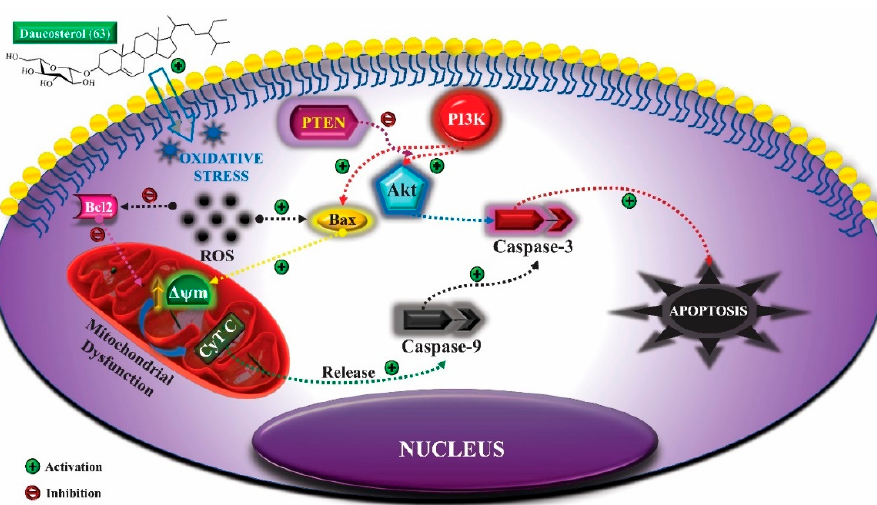
Figure 7. Daucosterol mechanism on human breast adenocarcinoma cells: After treatment of tumor cells (MCF-7) with daucusterol, a phytosterol abundantly present in Bromelia antiacantha extracts, the positive regulation of Phosphatase and Tensin Homologue (PTEN) blocks Protein Kinase B (Akt) activation through PI3K. Daucusterol induces reactive oxygen species (ROS) synthesis that leads to mitochondrial oxidative stress and, subsequently, release of cytochrome C. Subsequently, the activation of caspases causes cell apoptosis [202]. ∆ ψ m, mitochondrial membrane potential; Akt, Protein Kinase B; Bax, BCL2 Associated X; Bcl2, B-cell lymphoma 2; Cyt C, cytochrome C; PI3K, phosphatidylinositol-3-kinase; PTEN, phosphatase and tensin homologue; ROS, reactive oxygen